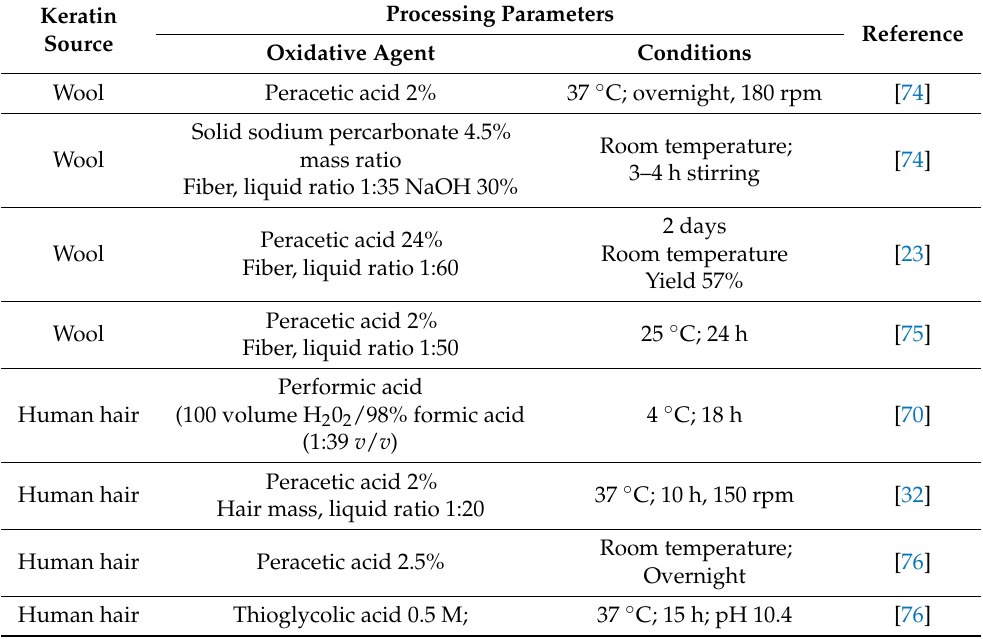
Table 2. Oxidation conditions and processing parameters for the keratin extraction.